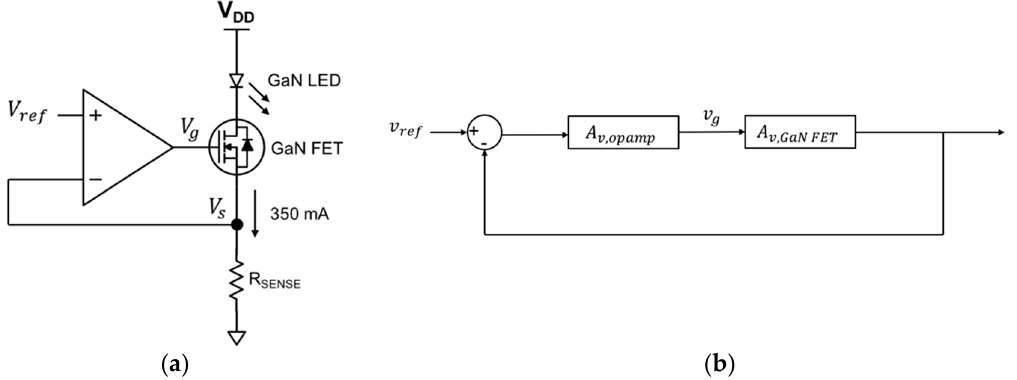
Figure 3. ( a ) Schematic and ( b ) block diagram of designed linear voltage regulator.